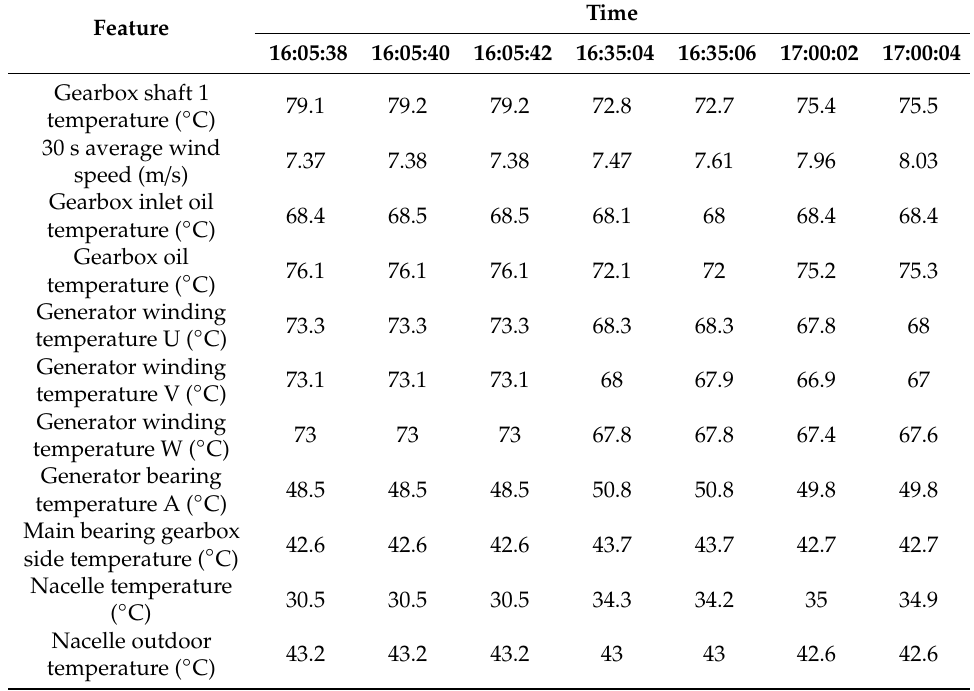
Table 1. Part of the raw data of wind turbines on May 12,